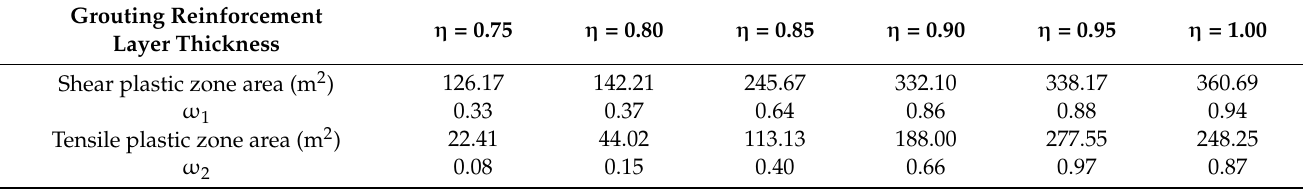
Table 5. Shear and tensile plastic zone area of surrounding rock under different water–cement ratios. Grouting Reinforcement Layer